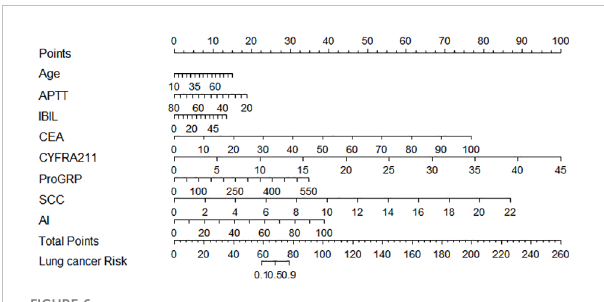
FIGURE 6 The application of the integrated nomogram